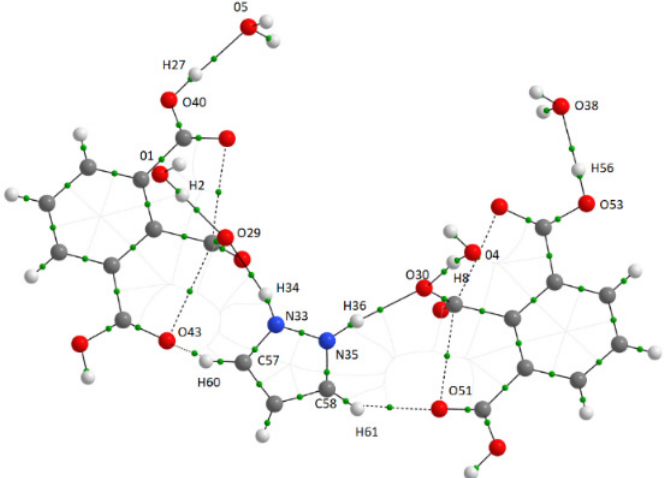
Figure 6. Molecular graphs (representation of bonding interactions according to QTAiM results) of the system analyzed in this study. Green circles correspond to the bond critical point. Table 2. Geometrical parameters (d H ⸱⸱⸱ o in Ångstrom and < D ‒ H ⸱⸱⸱ A in degrees) corresponding to the D ‒ H ⸱⸱⸱ A contacts obtained at the B3LYP/6-311++G(d,p); QTAiM parameters (in atomic unit) corresponding to the H ⸱⸱⸱ O bond critical point (BCPs), the electron density at BCP ρ BCP ; Laplacian of electron density at BCP, ∇ 2 ρ BCP ; total electron energy density at BCP, H C and the components of the H C : kinetic electron energy density, G C ; potential electron energy density, V C . The atomic la- beling is presented in Figure 6.